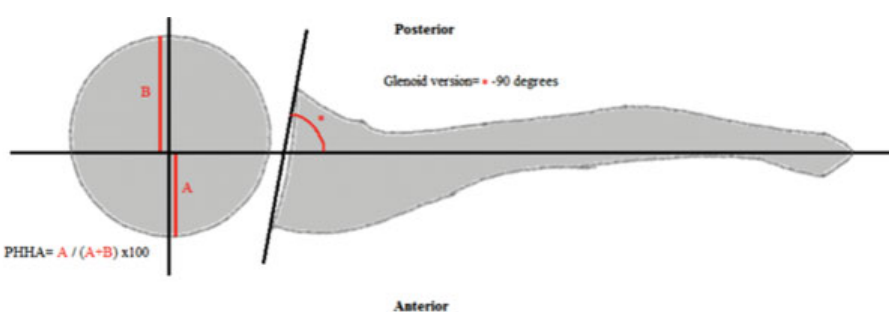
Fig. 1 Diagram depicting the method of measuring percentage of humeral head posterior anterior to the middle of the glenoid fossa (PHHA), and the glenoid version according to Friedman et al. 18 For PHHA, the length of the humeral head anterior to the middle of the spine of scapula is divided by the diameter of the humeral head. For glenoid version, the angle between the spine of scapula and the glenoid surface is measured and subtracted by 90